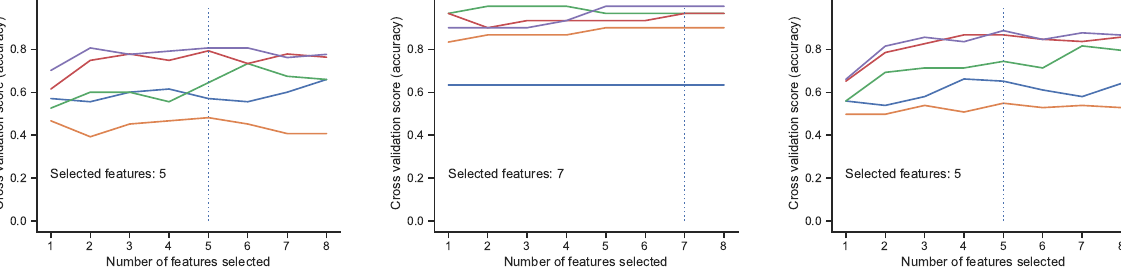
Figure 5. Feature selection based on 5-fold cross-validation scores. Each line represents a single run. The vertical dotted line indicates the number of features selected.